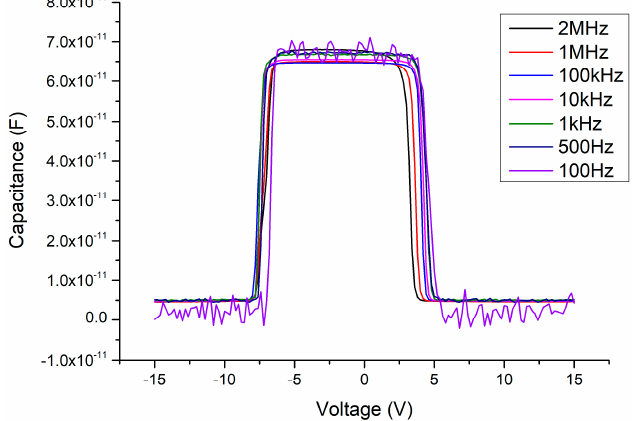
Figure 15. C–V measurement results of the MOSOM varactor (with a 156 nm thick Ga 2 O 3 thin film) from +15 to − 15 V.